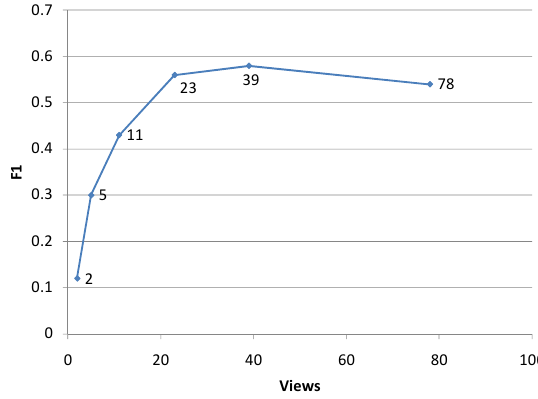
Figure 7. Experimental results for various numbers of views in the Parts Database (MatchThresh D 90